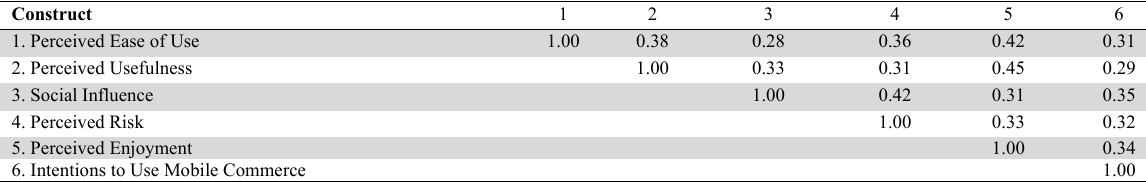
Constructs Inter-correlations Construct